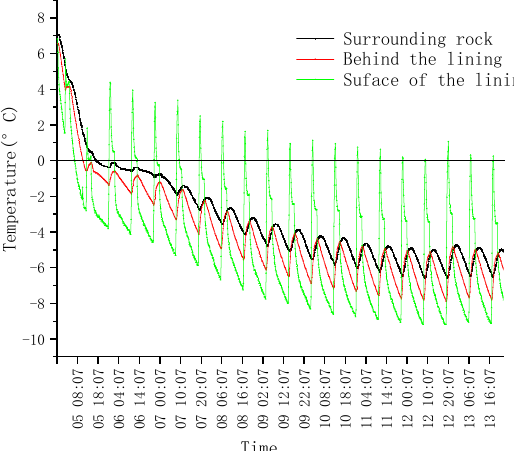
The temperature fluctuation of the surrounding rock, lining back, and lining surface is shown in Figure 12.